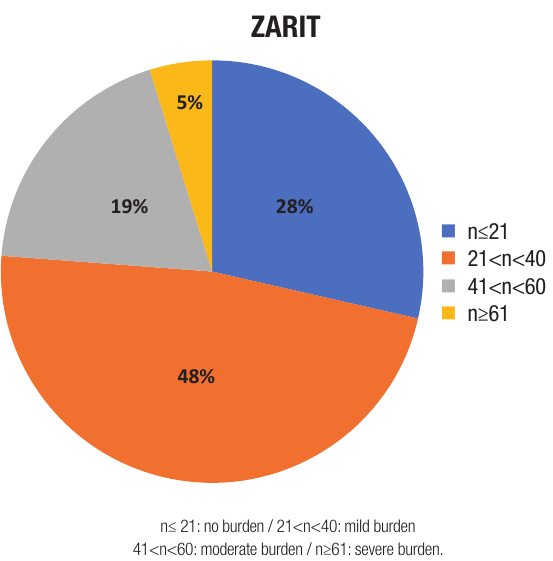
Figure 1. ZBI score distribution among caregivers